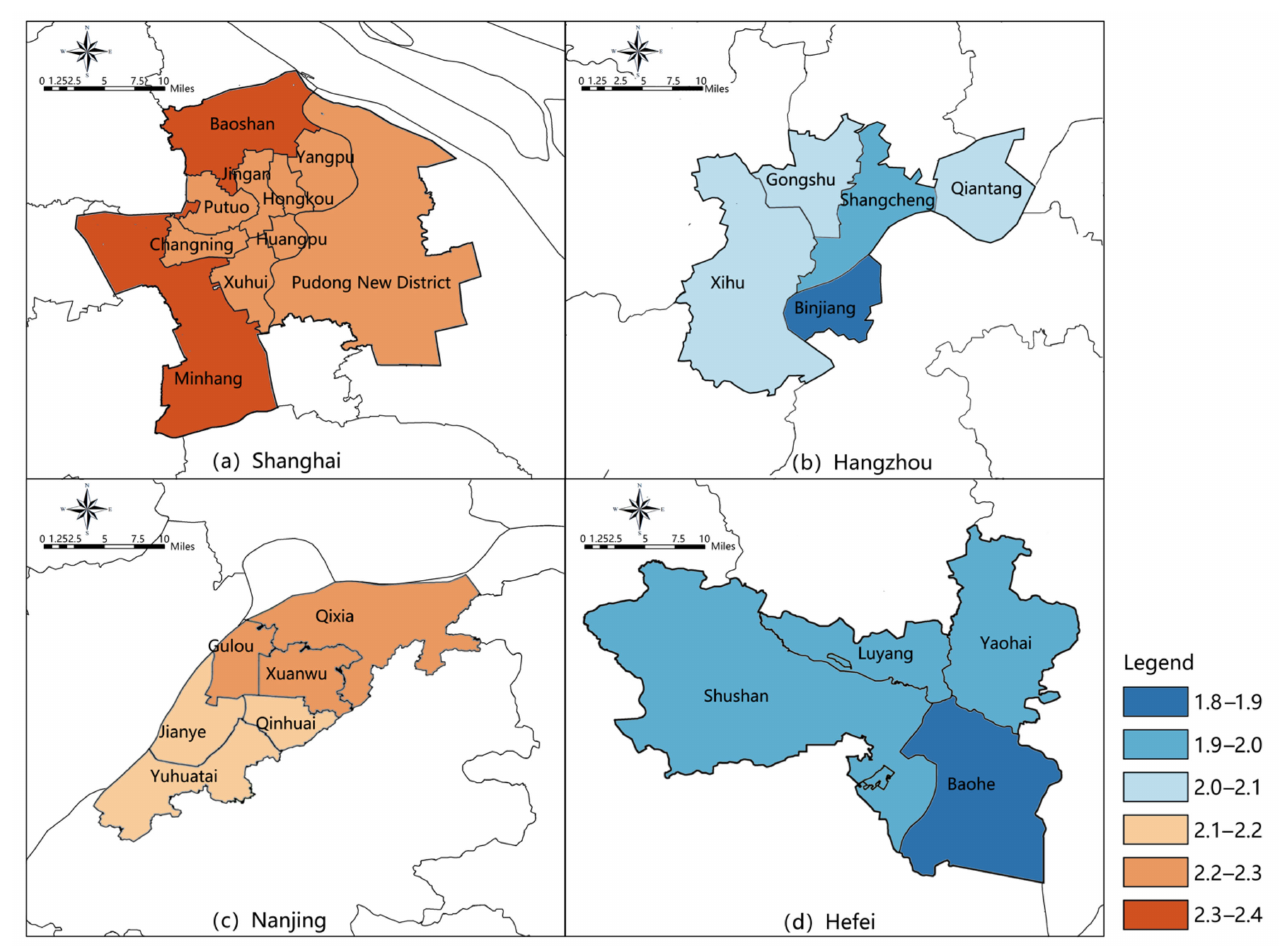
Figure 6. The CDI distribution of the administrative districts in the main urban areas of the four central cities in the